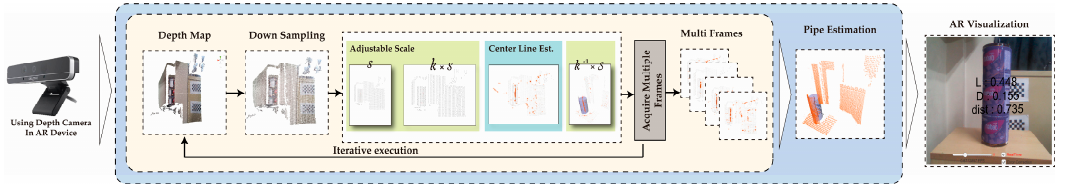
Figure 3. The proposed real-time augmented reality visualization method.